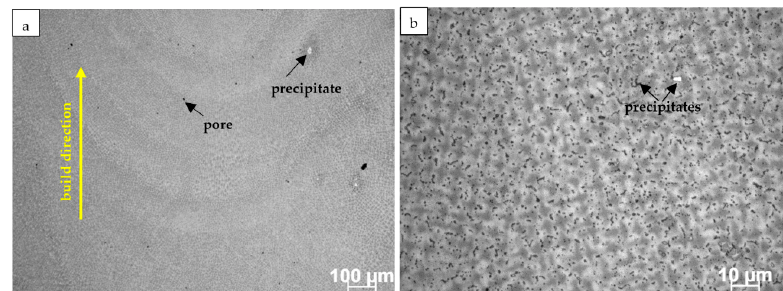
Figure 1. Light microscopy images of the L-DED Inconel 625 microstructure in as-built condition: ( a ) deposited layers with dendritic structure, exemplary pore and precipitate are marked by arrows and ( b ) larger magnification image showing the high density of precipitates, mostly located in interdendritic areas. Two size ranges of precipitates can be recognized on LM images. White etched precipitates with a size of a few micrometres are observed even at low magnification. Numerous small dark-etched particles are located mostly in the interdendritic areas (Figure 1b). Such observation demonstrates that, due to the dendritic solidification, the pronounced microsegregation of alloying elements occurs, which results in the formation of precipitates. TEM observations of the microstructure revealed numerous precipitates of various shapes in the